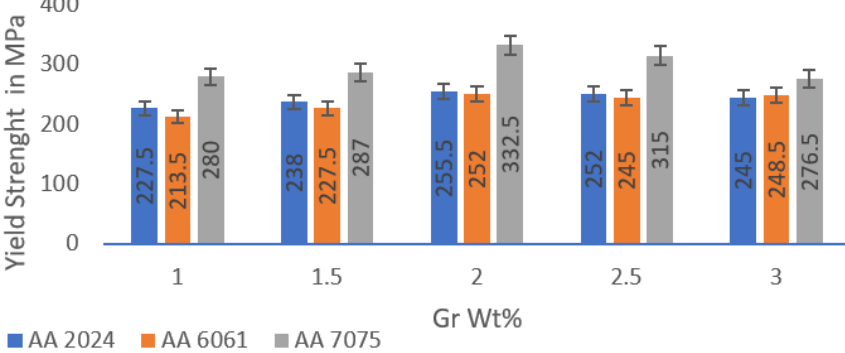
Figure 19. Yield Strength data of the microwave-processed Hot extruded Graphene Nano composites.